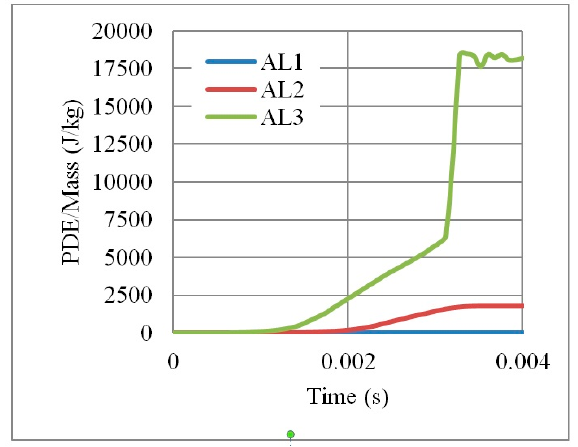
Figure 11. Ratio of PDE/Mass with respect to time, for 3 different Aluminium grades AL1, AL2 and AL3, of an auxetic core with L = 10 mm, t = 2mm, t/L = 0.2.